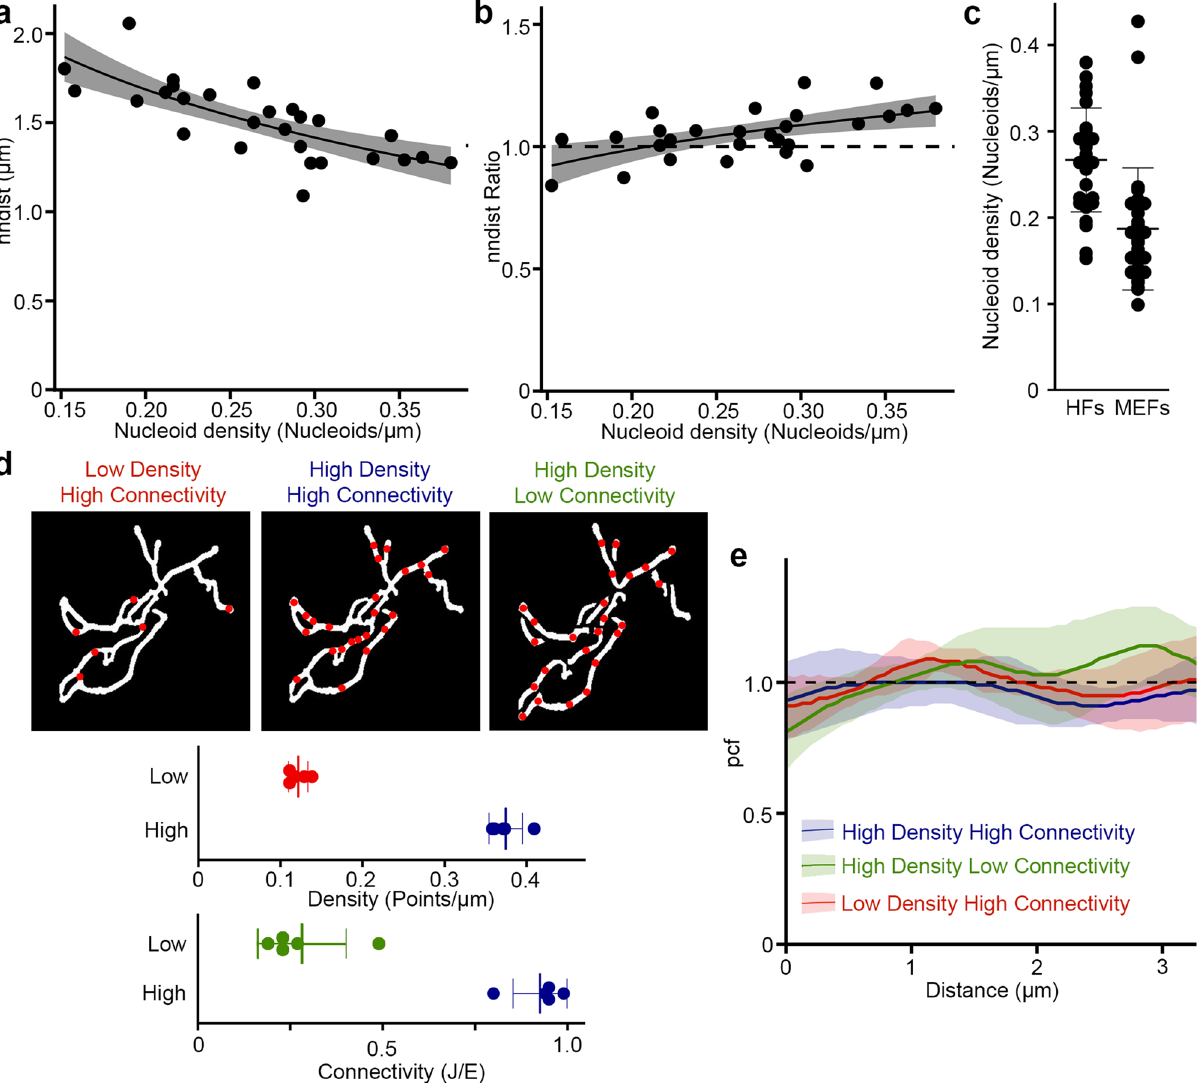
Figure 2. Measurement of nucleoid distribution by Mitomate tracker. ( a , b ) nndist is dependent on point density even after normalization. Scatter plot of Actual ( a ) and normalized (relative to an IRP; b ) nndist values relative to nucleoid density in primary human fibroblasts. Each data point represents an individual cell (n = 27). The dashed line represents a random distribution. Linear regression formula y ~ log(x). ( c ) Nucleoid density in primary human fibroblast (HF) and mouse embryonic fibroblast (MEF) cells. Each point represents an individual cell. ( d , e ) Network connectivity and point density do not affect the pcf of random point distribution. ( d ) The networks were either left connected or manually unbranched and overlayed with a low or a high point density. Top, Representative test network used for the analysis. Bottom, measures of point density and network connectivity for the 5 test networks. Each point represents a distinct network. ( e ) pcf curves. Solid lines represent the average point distribution for the indicated conditions and the shaded areas, the SD (n = 5 images). The dashed line represents the expected random